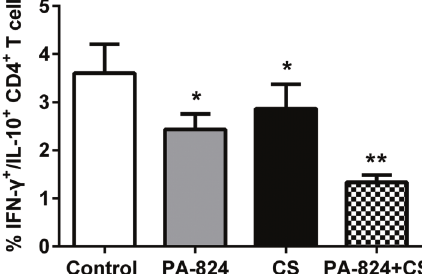
Figure 4. Relative IFN- g and IL-10 double-positive CD4 + cells in peripheral blood of infected mice after administration of PA-824, CS or the combination of both, measured by fl ow cytometry. CS: Cordyceps sinensis (Berk.) Sacc.; IFN- g : interferon- g ; IL-10: interleukin-10. *P o 0.05, **P o 0.01, compared to control (ANOVA).